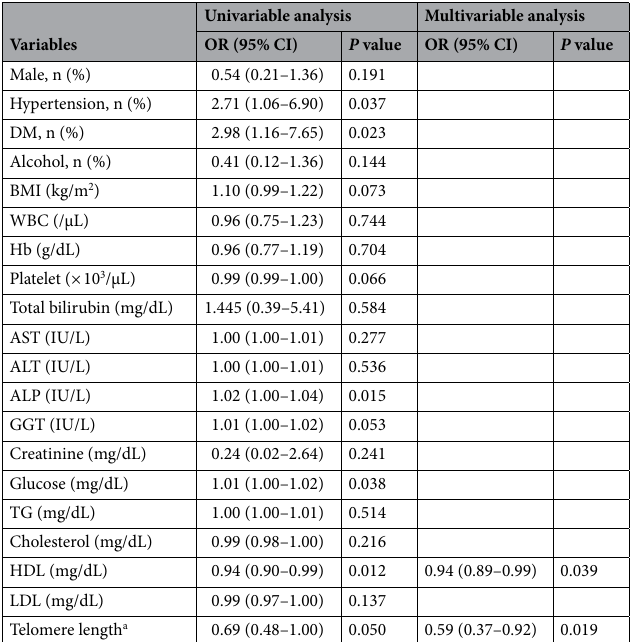
Table 2. Independent predictors of significant fibrosis in NAFLD patients. Table 2 enrolled parameters with p value ≤ 0.05 in univariate analysis into multivariate analysis. a = age-adjusted telomere length. DM diabetes mellitus, BMI body mass index, WBC white blood cell, Hb hemoglobin, AST aspartate aminotransferase, ALT alanine aminotransferase, ALP alkaline phosphatase, GGT gamma-glutamyl transferase, TG triglycerides, HDL high-density lipoprotein, LDL low-density lipoprotein.